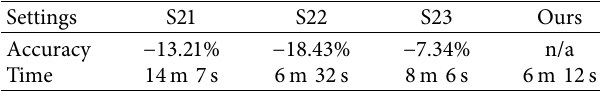
Table 7: Accuracy decrement ( − )/increment (+) and time cost of different algorithms on [9].